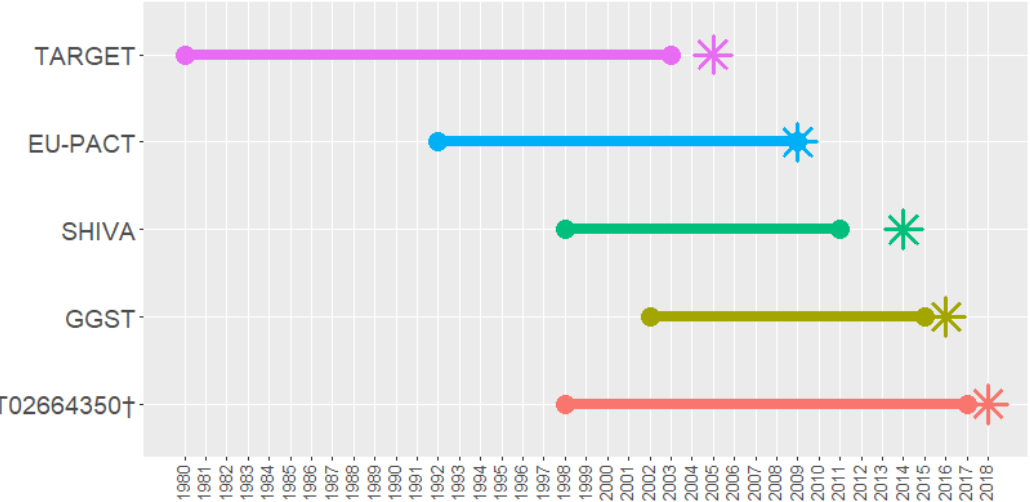
Figure 1. Timings of publications cited by each trial. Star icons indicate the date of publication of the † results not yet paper or protocol references were extracted from. †results not yet published. paper or protocol references were extracted from.